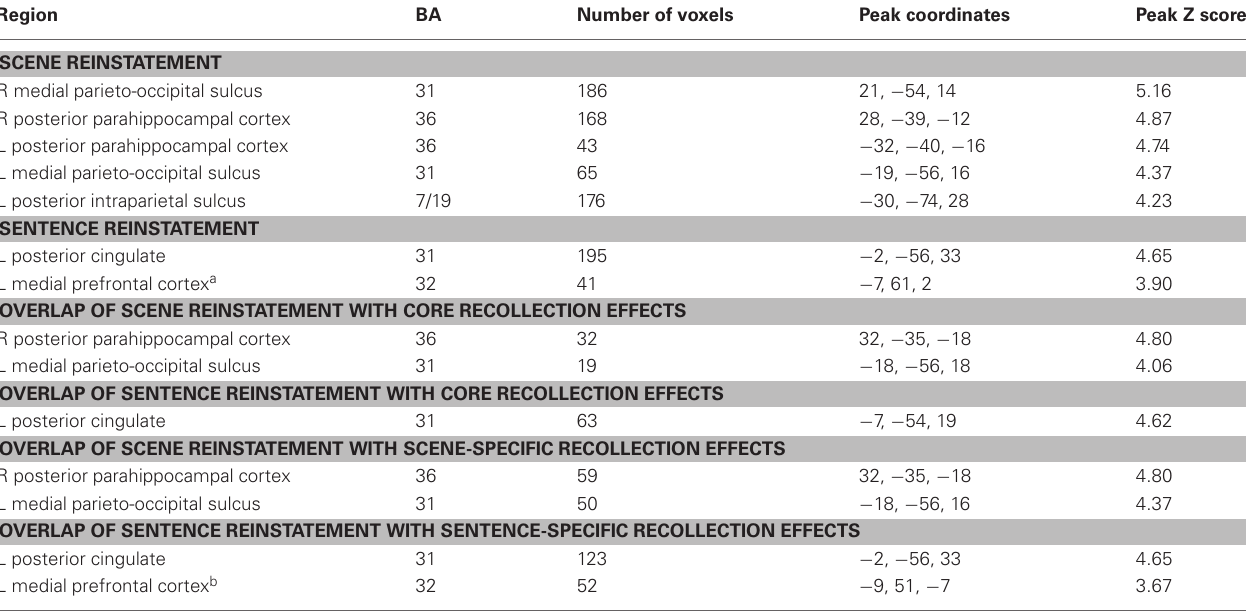
Table 5 | Regions exhibiting content-sensitive reinstatement effects. Region